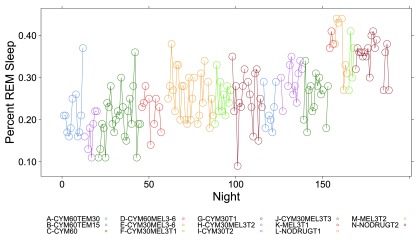
Percent REM sleep per night.The percent time subject was in REM sleep during 5-minute intervals detected by the Zeo Sleep Monitor throughout the entire study. Dosages of Cymbalta (CYM60 = 60 mg, CYM30 = 30 mg), temazepam (TEM30 = 30 mg, TEM15 = 15 mg) and melatonin (MEL3 = 3 mg, MEL6 = 6 mg) were varied according to combinations A-N (T1, T2, T3 are trial replicates), including no drug trials (L, N).